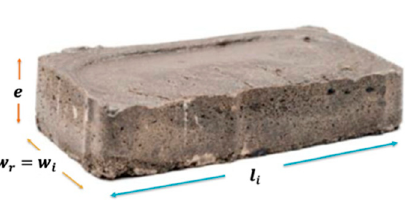
Figure 4. Representation of variables involved in Modulus of Rupture.